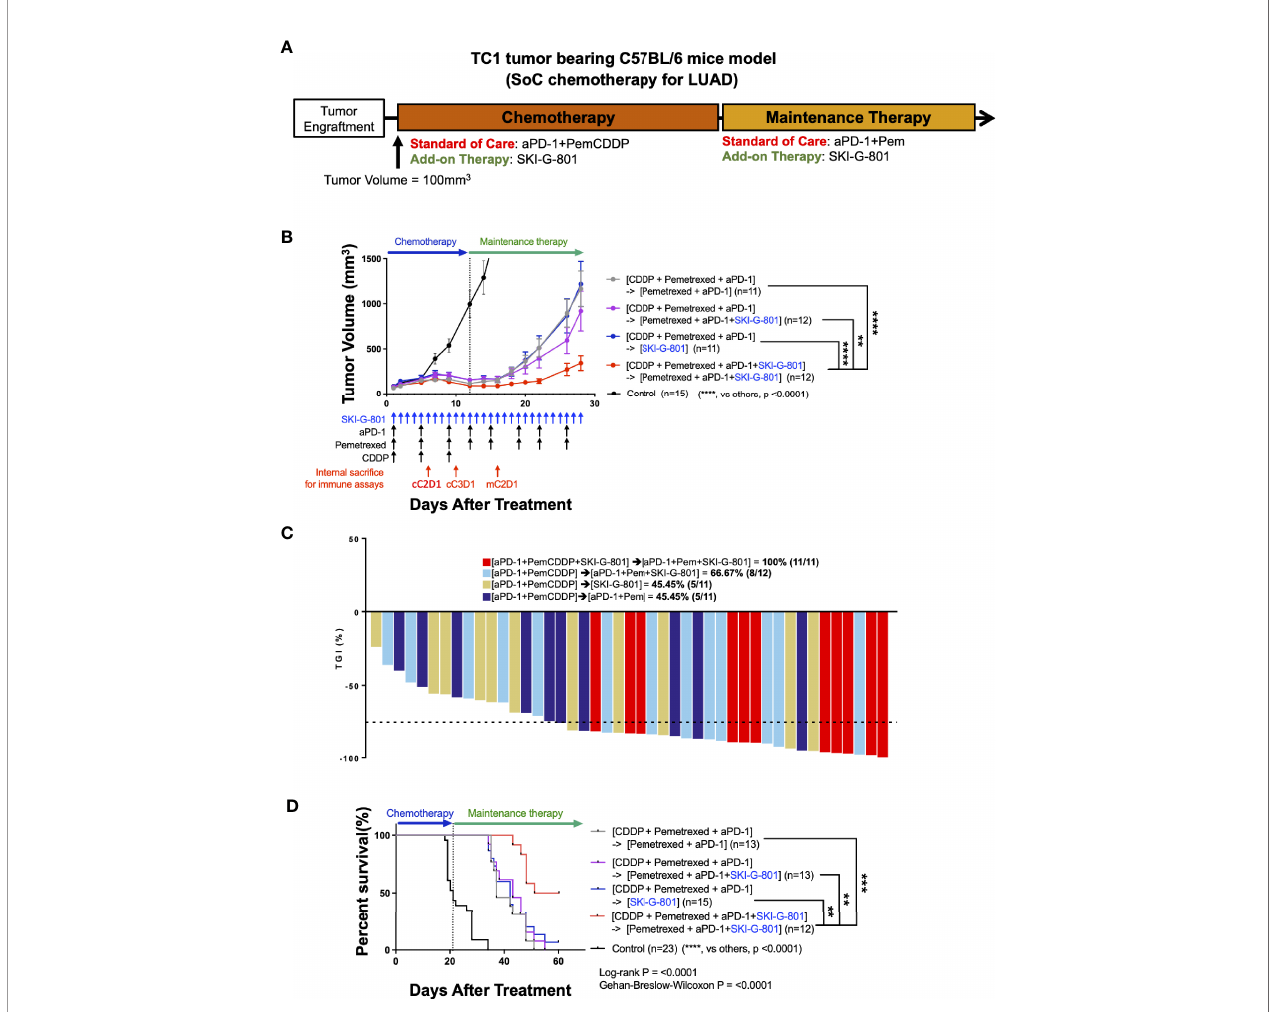
FIGURE 1 | Upfront AXL inhibitor add-on delayed tumor growth, enhanced tumor growth inhibition, and improves survival in combination with SoC chemotherapy for LUAD in TC1 model (A) Syngeneic TC1 tumor cells were injected into C57BL/6 mice and treatment was initiated when the tumor volume reached 100 mm 3 . [aPD-1 + Pem + CDDP] were administered as standard of care for chemotherapy, and aPD-1 and Pem were administered as standard of care for maintenance therapy. (B) AXL inhibition by SKI-G-801 with standard of care signi fi cantly delayed the growth of TC1 xenografts in C57BL/6 mice. Red arrows indicate sampling points during the treatment schedule (SKI-G-801 30 mg/kg, QD; Pem 100 mg/kg, BIW; CDDP 5 mg/kg, BIW; aPD-1 10 mg/kg, BIW). Mean tumor volumes for each group and SEM images are shown. (C) Tumor growth inhibition was enhanced by upfront addition of SKI-G-801, with all of the mice in the [aPD-1+PemCDDP+SKI- G-801] ! [aPD-1+Pem+SKI-G-801] group showing more than 75% TGI. Dashed line indicates -75% TGI. (D) Upfront AXL inhibition signi fi cantly enhanced the overall survival of TC1 tumor-bearing C57BL/6 mice. Statistical signi fi cance between groups was calculated using one-way ANOVA followed by Tukey ’ s